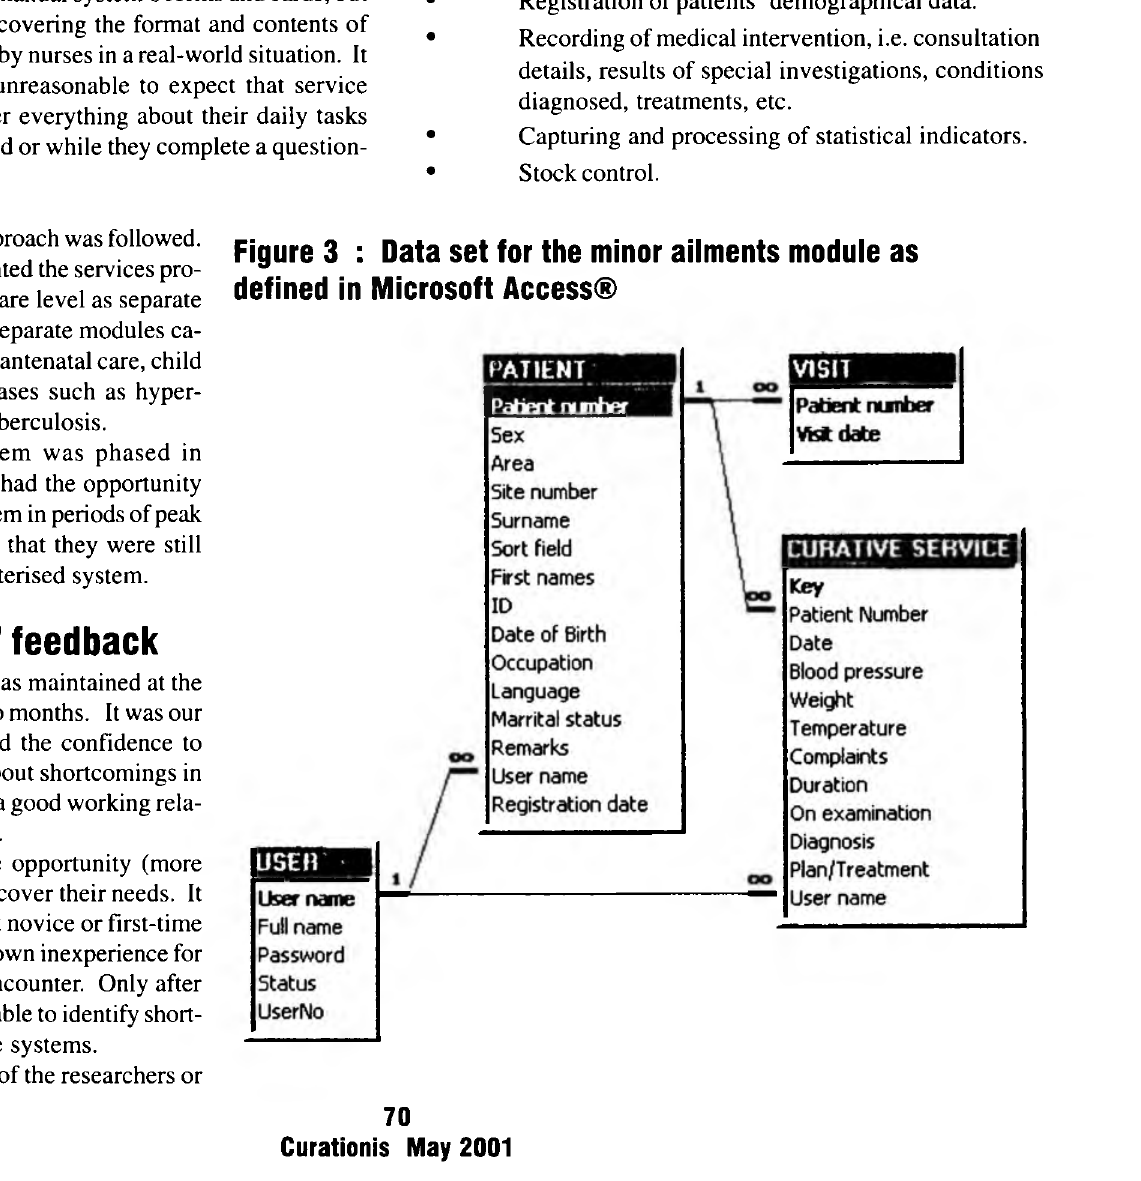
Figure 3 : Data set for the minor ailments module as defined in Microsoft